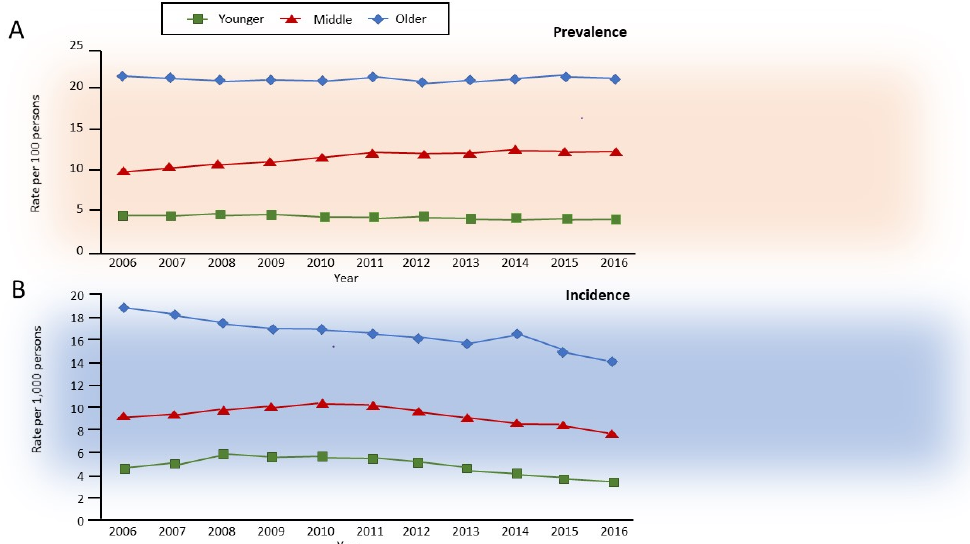
Figure 1. Annual age ‐ specific standardized ( A ) prevalence and ( B ) incidence of chronic obstructive pulmonary disease in Ontario, Canada, 2006–2016. Rates are sex ‐ standardized to the 2016 Ontario population, with age groups defined as younger, 35–54 years old; middle, 55–64 years old; and